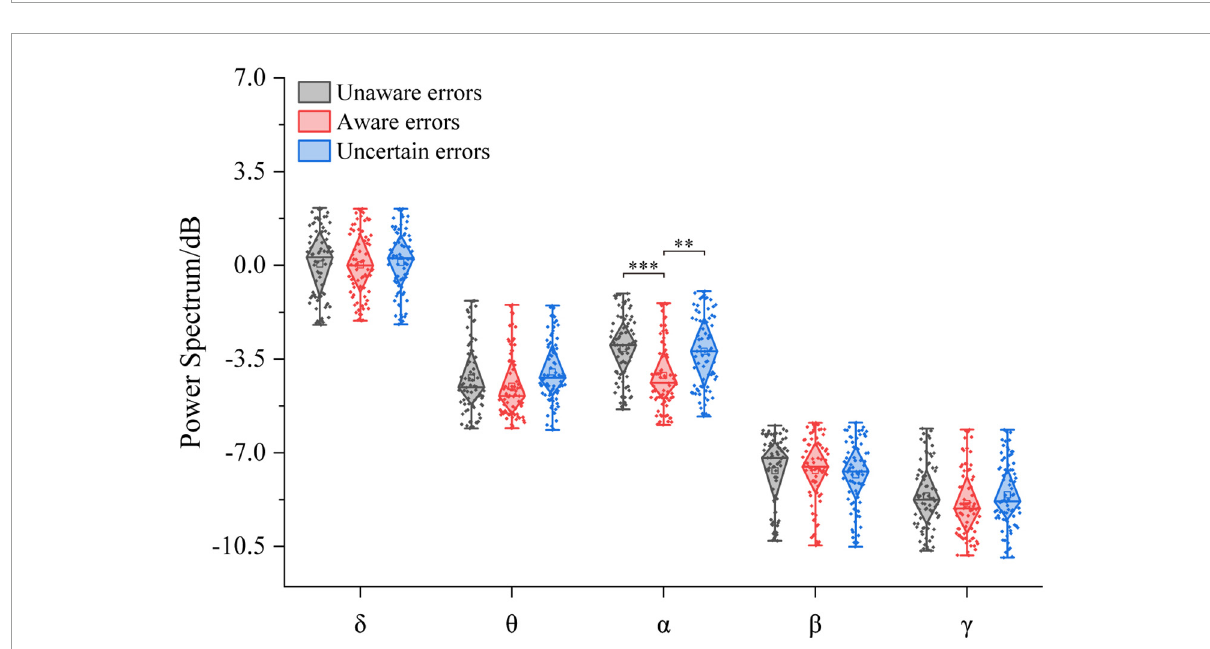
FIGURE5 Power spectral density corresponds to multiple error awareness in each frequency band ( n = 78). The squares in the box plots indicated the mean values, the horizontal lines indicated the medians, and both ends indicated the maximum and minimum values ( ∗∗ p < 0.001, ∗∗∗ p <